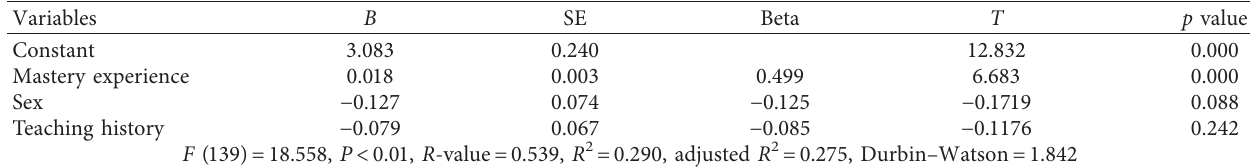
Table 5: Influence of mastery experience on preservice accounting teachers’ self-efficacy. Variables